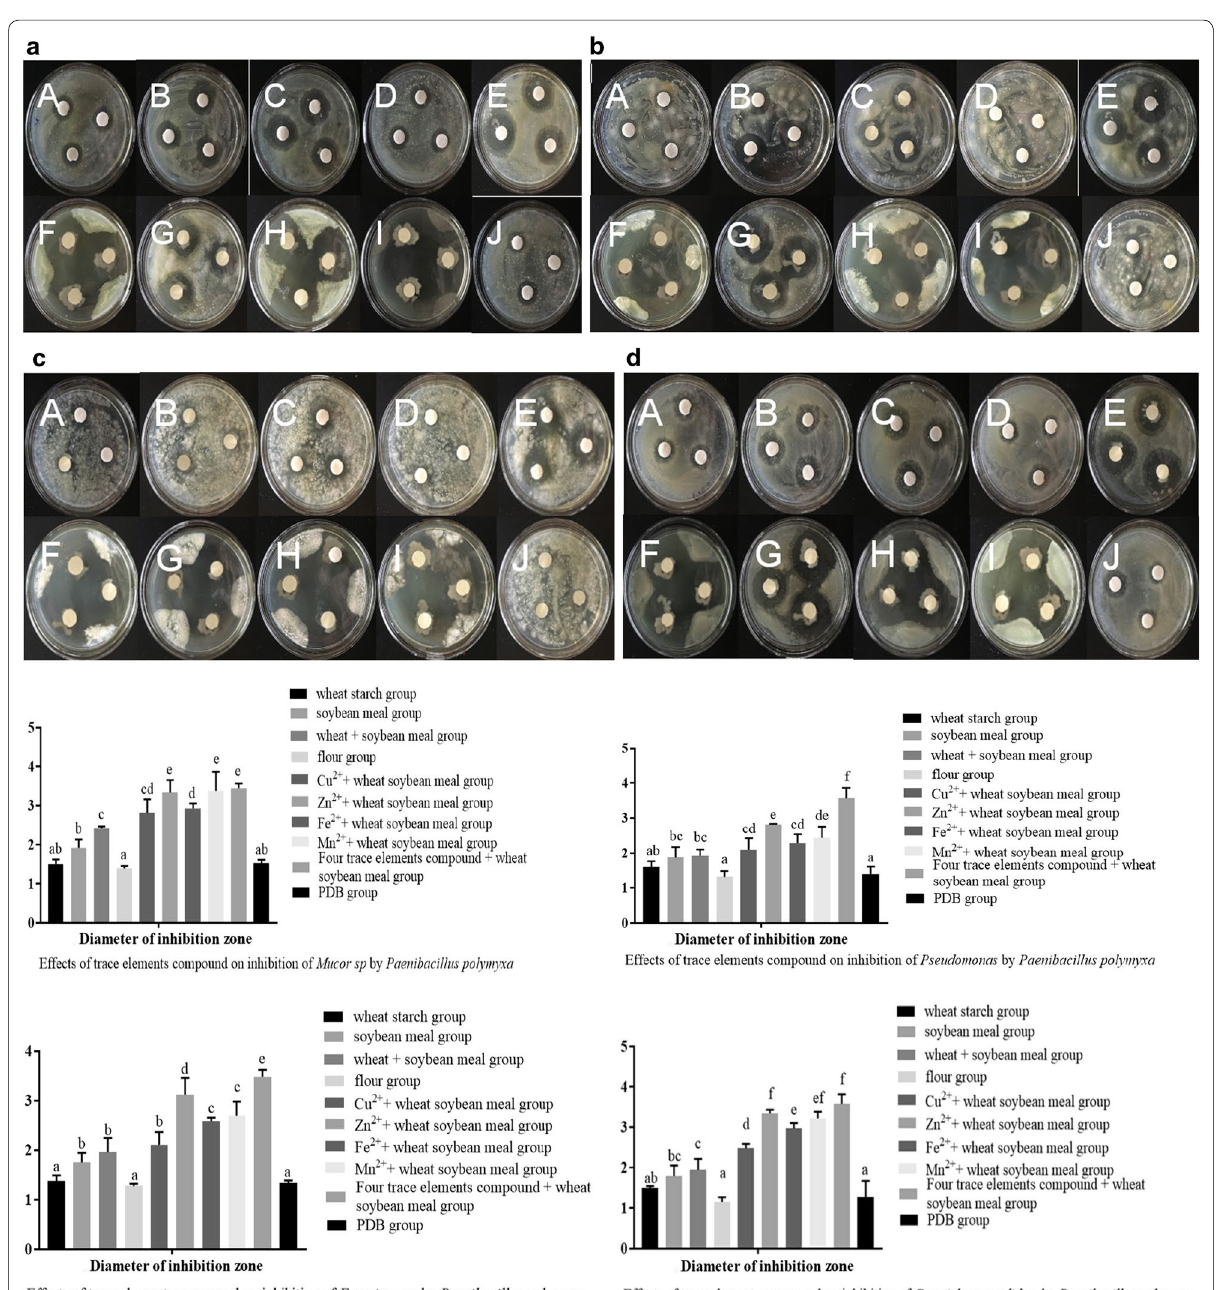
Fig. 3 Effects of four trace elements on the antibacterial activity of Pp-7250. a, Muco r sp.; b, Fusarium sp.; c, Geotrichum candidum ; d,